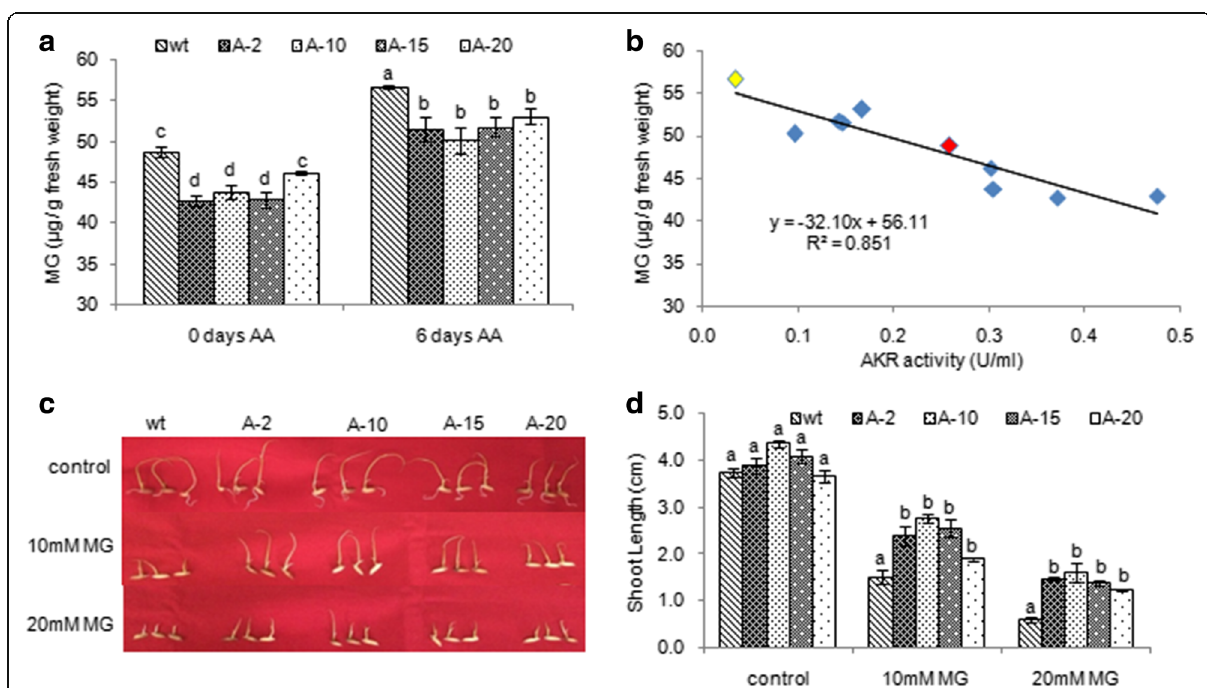
Fig. 6 The rice transgenics expressing PsAKR1 gene showed reduced methylgloxal (MG) levels in seeds under ageing conditions. a MG levels in transgenics and wild type seedlings under control and 6 days of accelerated ageing, b Correlation between reduction in MG with increased AKR activity, c Response of wild type and transgenic seedlings to 10 mM and 20 mM MG after 4 days of treatment, d Shoot length of wild type and transgenics seedlings on MG treatment, n = 10. Red and yellow dots represent values for wild type in control and ageing conditions